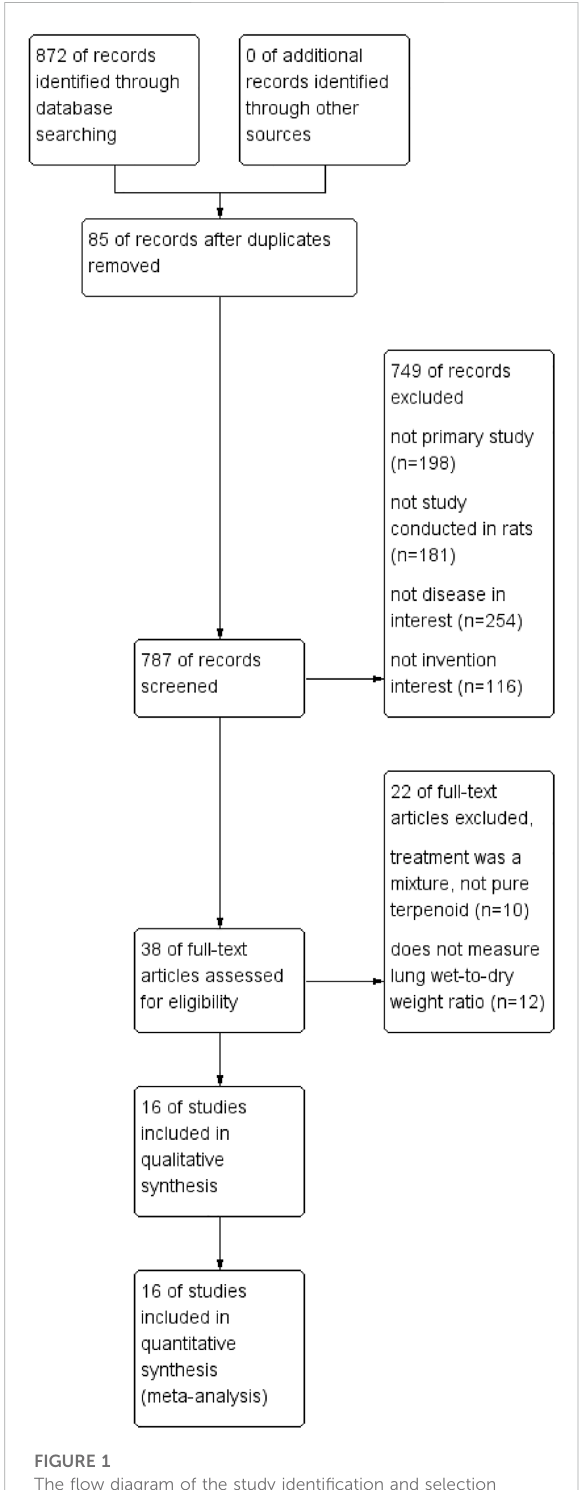
FIGURE 1 The fl ow diagram of the study identi fi cation and selection